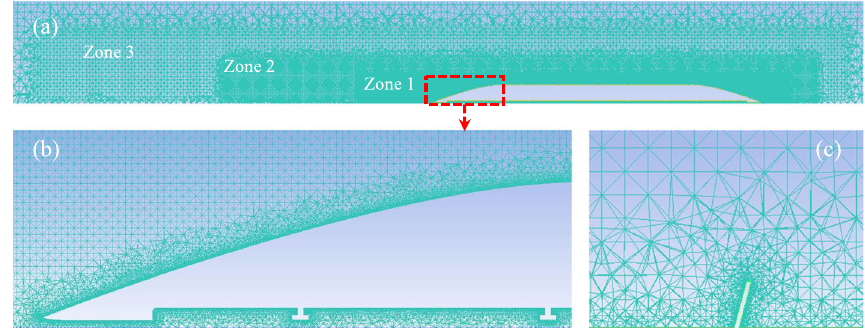
Fig. 4 Configuration of medium computational mesh: ( a ) the mesh refinement zone; ( b ) the cross-section mesh around the streamline of the tail car; ( c ) the mesh around the braking plate